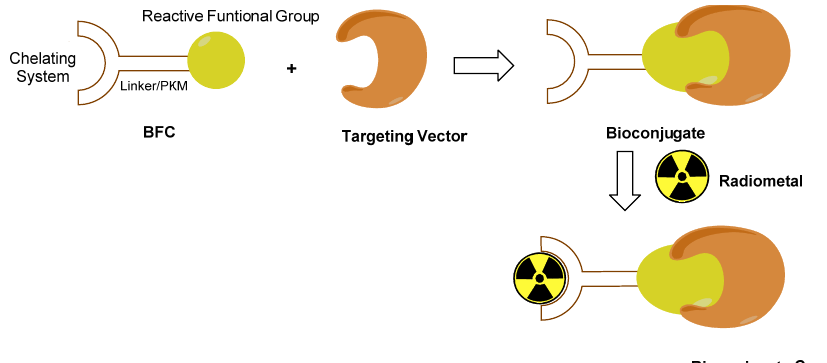
Figure 5. Representation of the biFuntional approach. By this approach, an RP can be described as mainly composed of two essential parts: the targeting vector, i.e., the molecule or macromolecule that drives the radiometal to the pertinent molecular target, and the chelating system (also known as the BiFuntional Chelator, (BFC) designed to promptly and robustly bind the metal radionuclide, preventing it’s in vivo leakage, and to carry another reactive group able to form a strong covalent bond with the targeting vector, thus yielding a kinetically and thermodynamically stable construct. These two parts are directly bound or are held together by an appropriate linker or pharmacokinetic modifier (PKM). The final compound (bioconjugate complex) is then obtained through the appropriate labeling procedure, which depends on the specific radiometal.